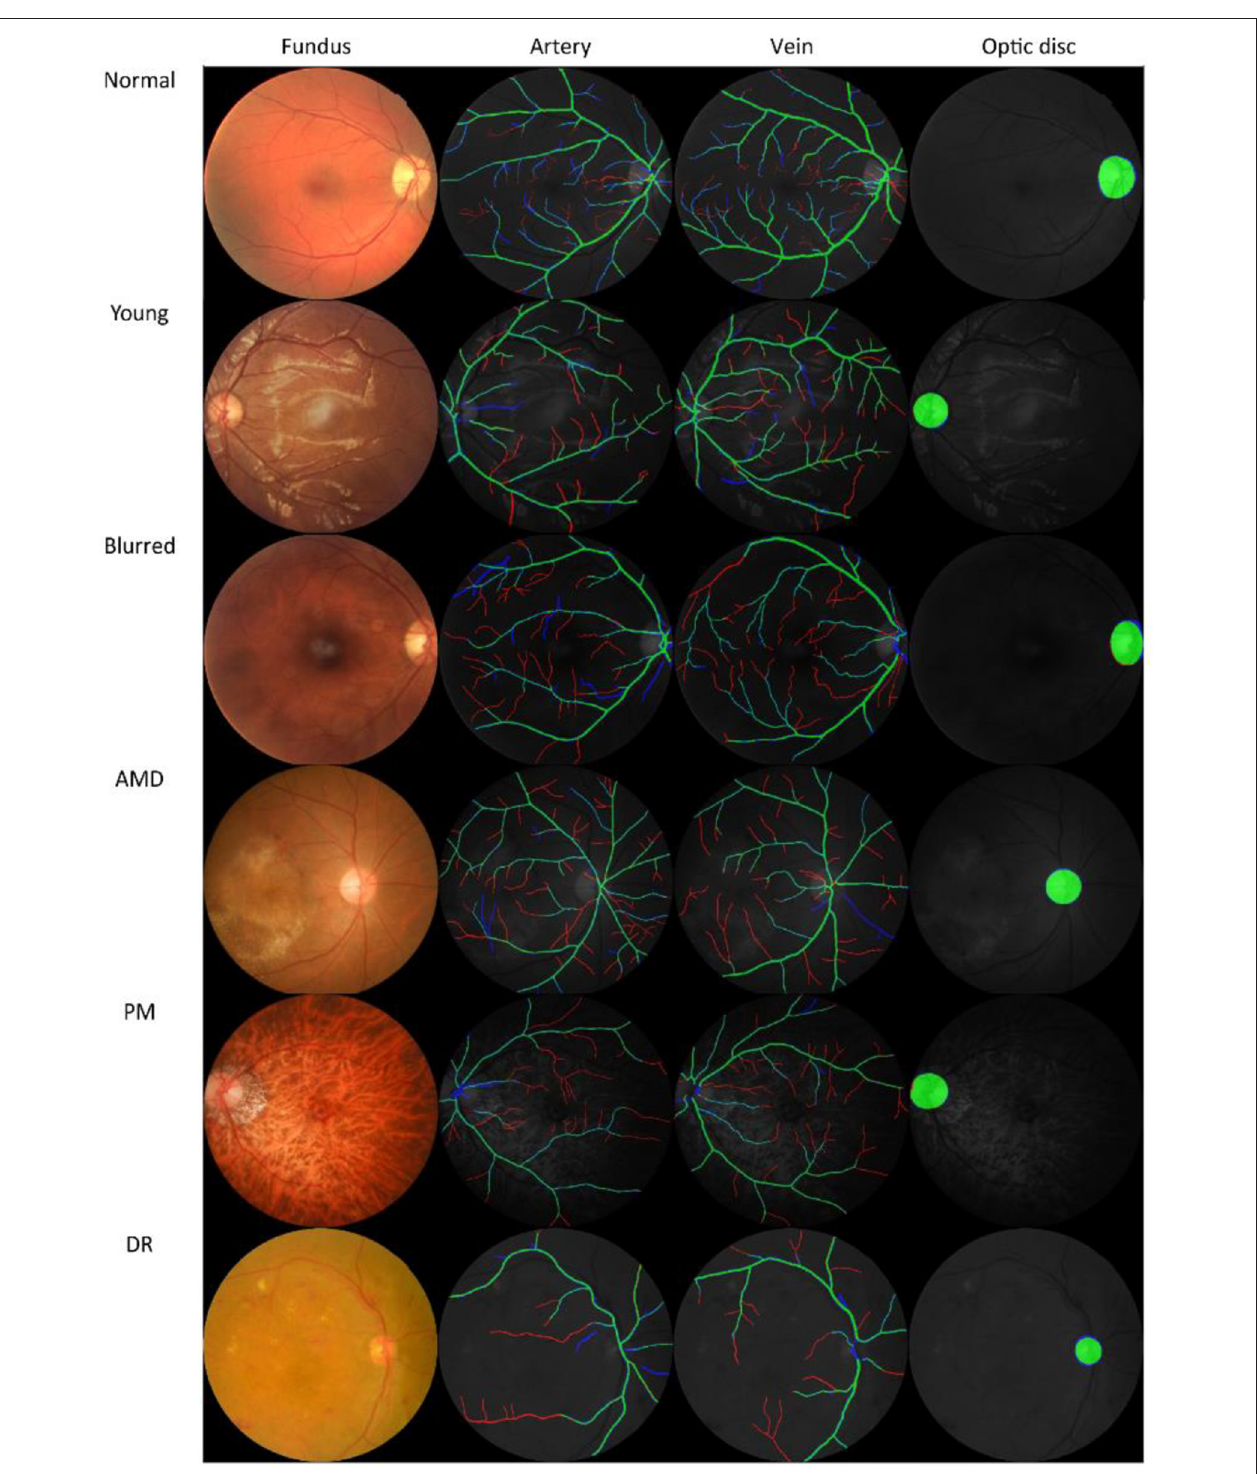
FIGURE 3 | Examples of model prediction by Retina-based Microvascular Health Assessment System (RMHAS) versus manual segmentation. Blue pixels: false negatives (pixels that were manually labeled but missed by the model). Red pixels: false positives (pixels identified by the model but missed by manual labeling). Green pixels: pixels with consistent segmentation between model and manual labeling. AMD, age-related macular degeneration; PM, pathologic myopia; DR, diabetic retinopathy.